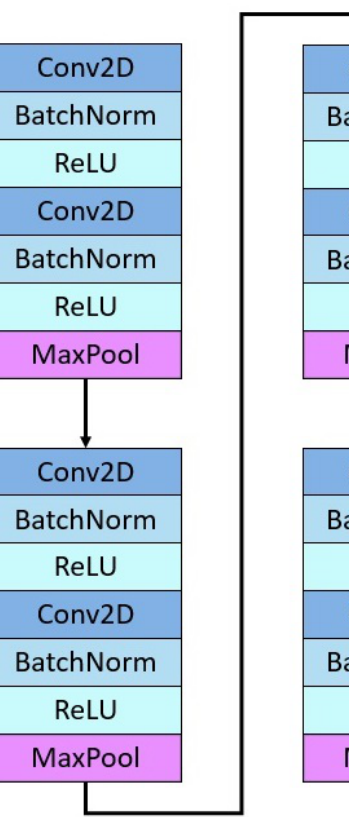
Figure 8. Convolutional Neural Network Architecture.